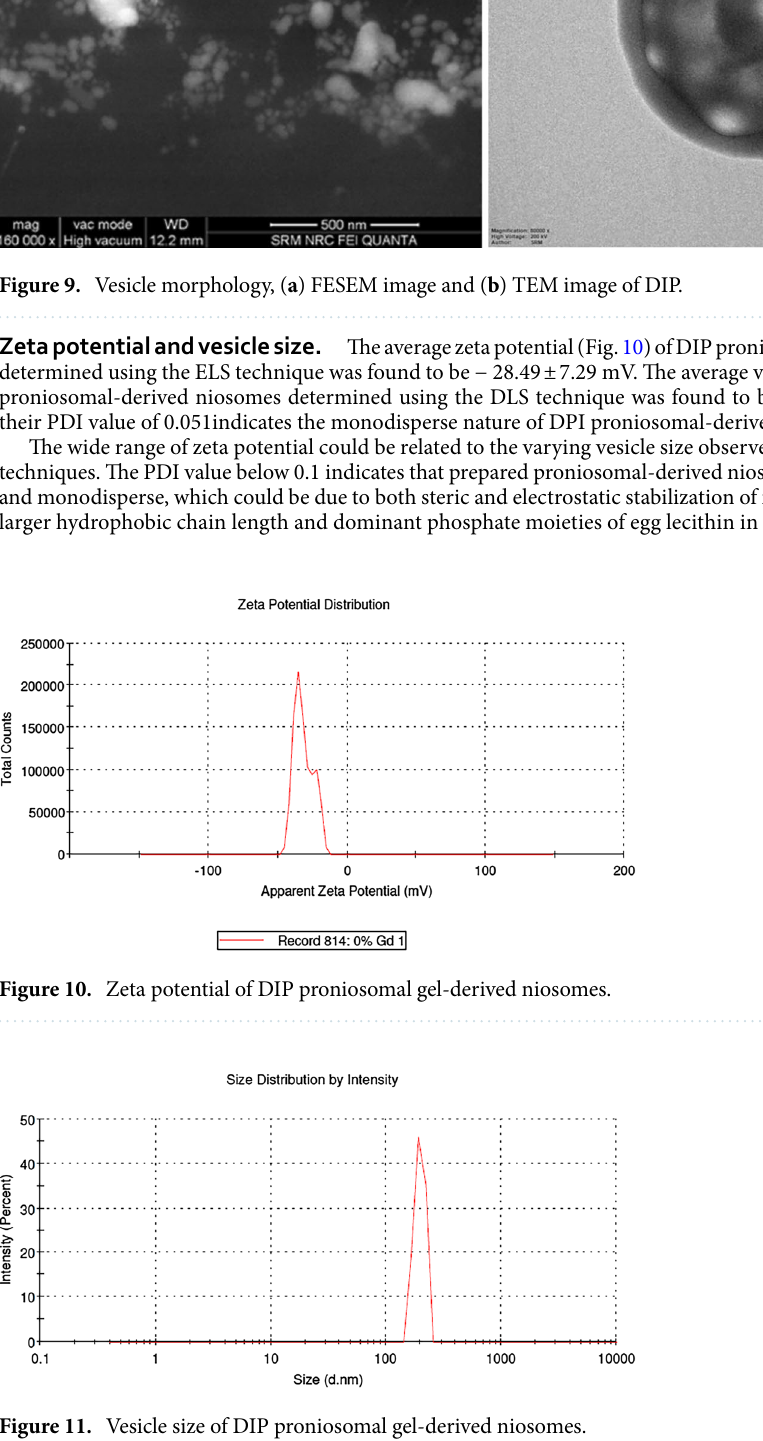
Figure 11. Vesicle size of DIP proniosomal gel-derived